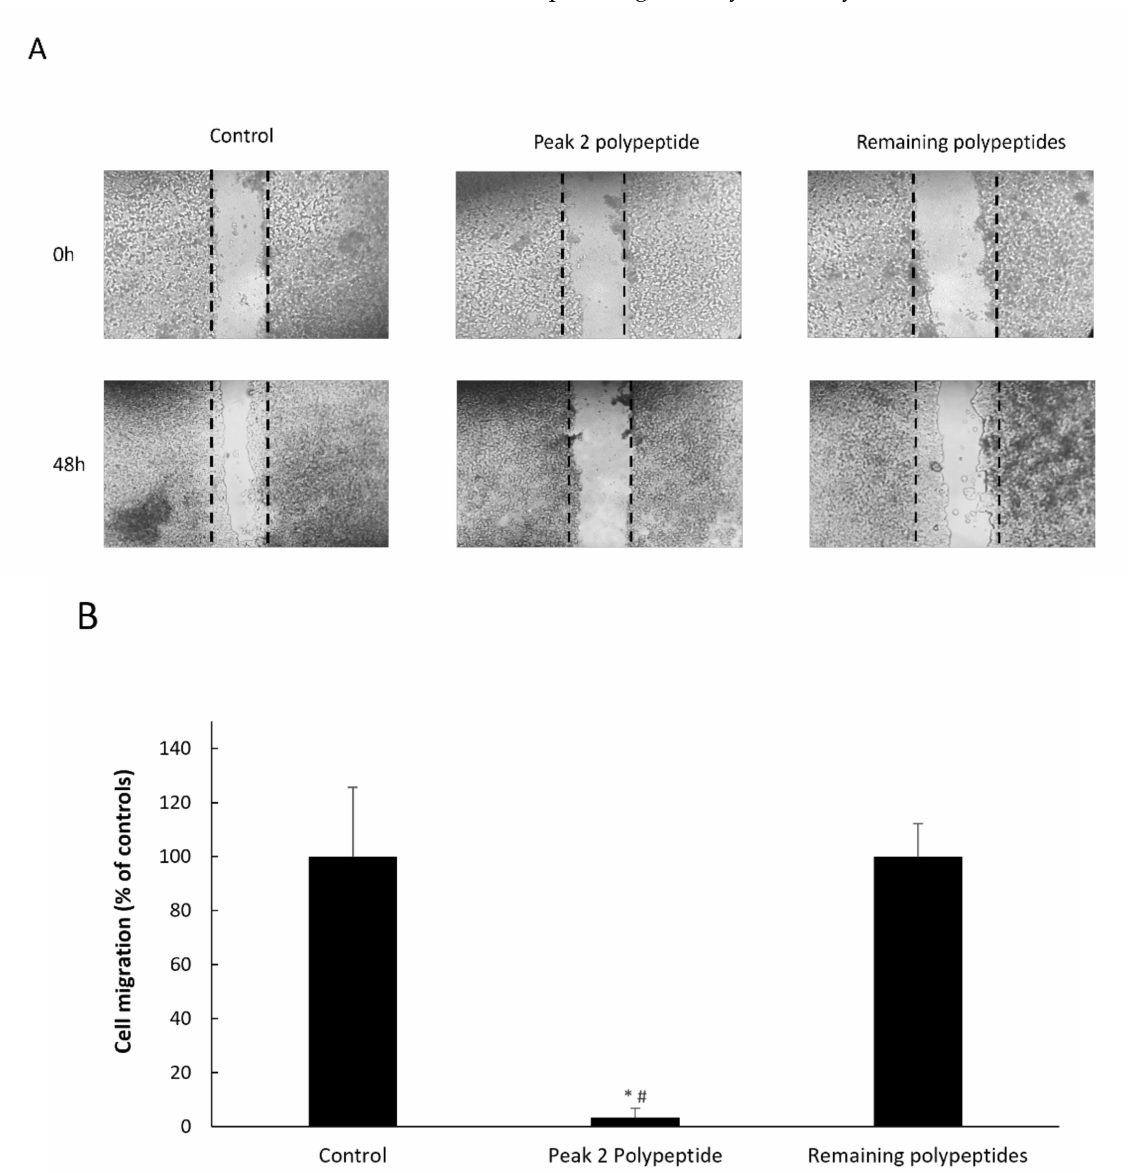
Figure 6. Peak 2 polypeptide inhibits HT29 colon cancer cell migration. ( A ) Examples of cell migration showing the inhibitory effect of different fractions of polypeptides. Cells were grown until reaching 80% confluence, and the monolayer was scratched with a pipette tip (day 0). Cells were then exposed to 100 µ g protein/mL of peak 2 polypeptide, and the cell gap invasion was registered after 48 h and compared with the length of the same gap at 0 h. ( B ) Relative migration rates. Values are the means of at least three replicate experiments ± SD and are expressed as % wound closure in relation to day 0. * represents p < 0.001 between samples, and # represents p < 0.001 when compared to